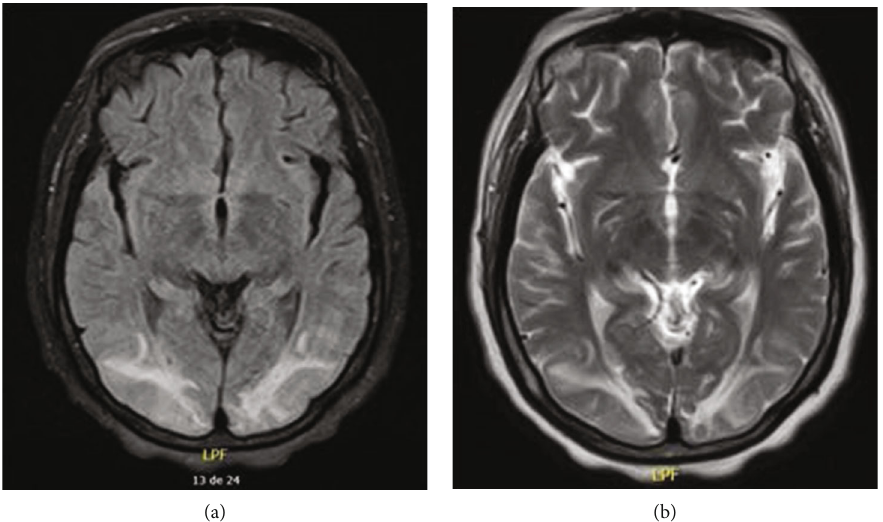
Figure 1: Brain MR of case 1. (a) Fluid-attenuated inversion recovery sequence showing occipital hyperintensities in occipital gyri. (b) T2- weighted sequence of the same patient showing hyperintensities in the occipital lobe.